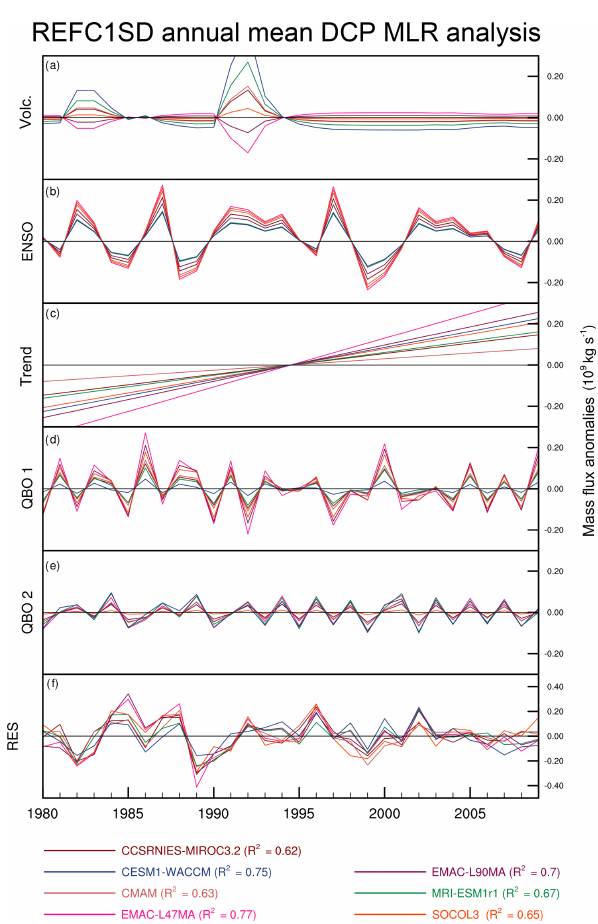
Figure 10. Time series for REF-C1 simulations of the compo- nents of the annual mean tropical upward mass flux ( × 10 9 kgs − 1 ) attributed to (a) volcanic aerosol, (b) ENSO, (c) linear trend, (d, e) QBO, and (f) regression residuals.